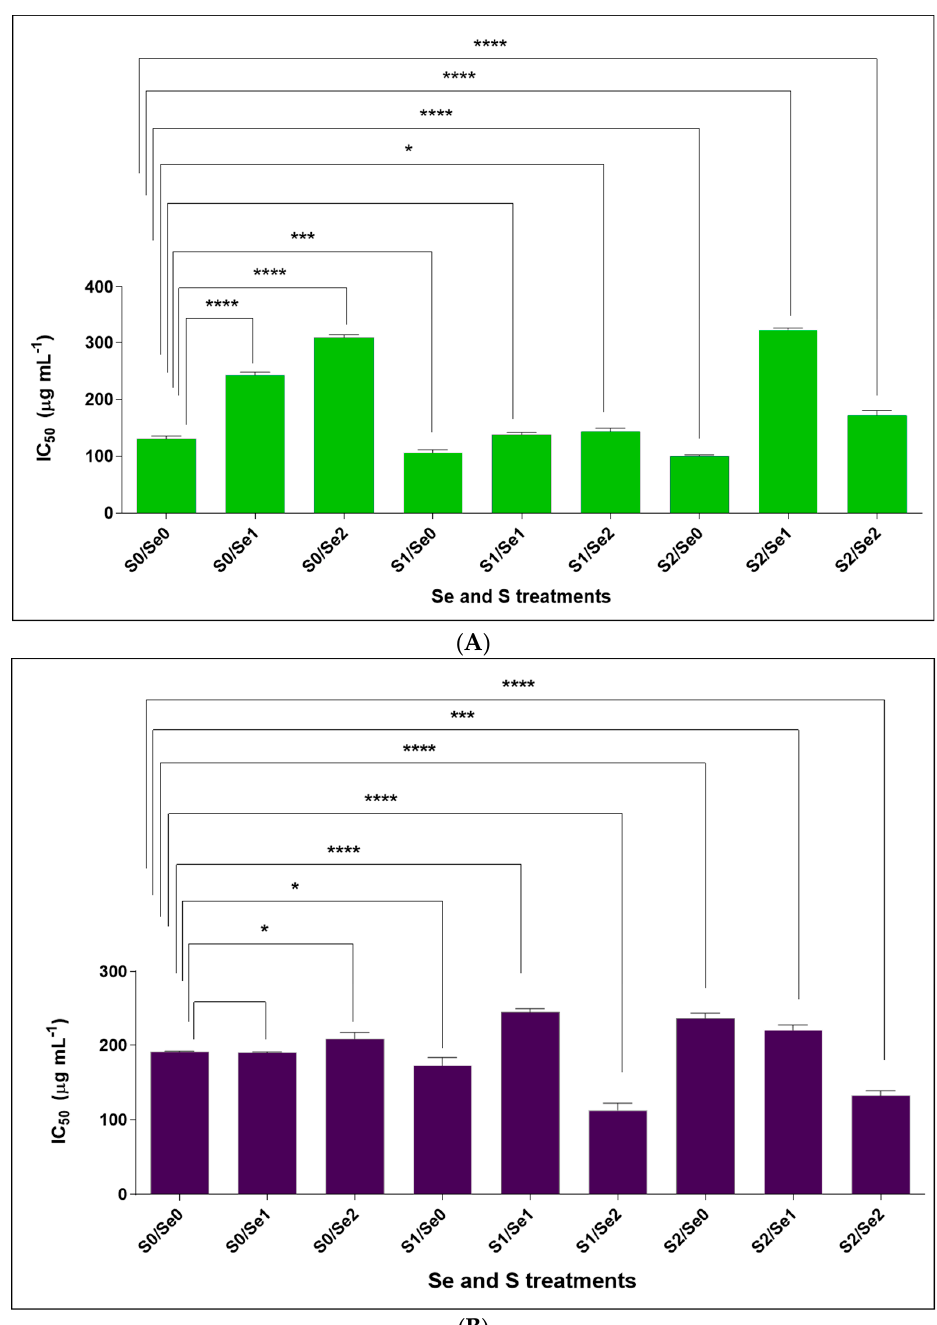
Figure 4. NO inhibitory effect of ( A ) green and ( B ) red lettuce plants grown in a hydroponic system and treated with three S levels (S0: 0, S1: 1 mM and S2: 1.5 mM K 2 SO 4 ) and three Se levels (Se0: 0 µM, Se1: 0.2 µM and Se2: 2.6 µM Na 2 SeO 4 ). The data presented are the means ± standard error of